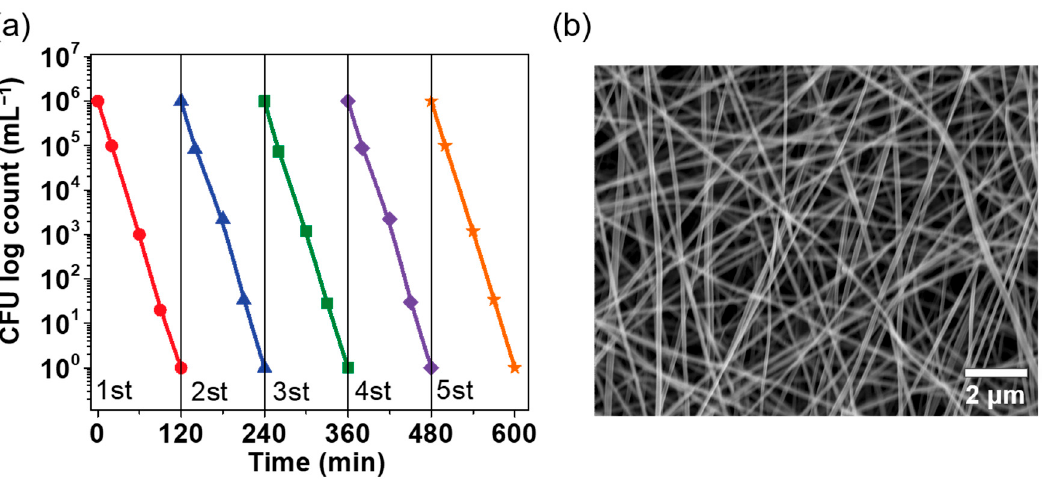
Figure 7. ( a ) Biocidal activity of the G-SF/PVA BNM through five cycles. ( b ) SEM images of the G-SF/PVA BNM after five cycles.